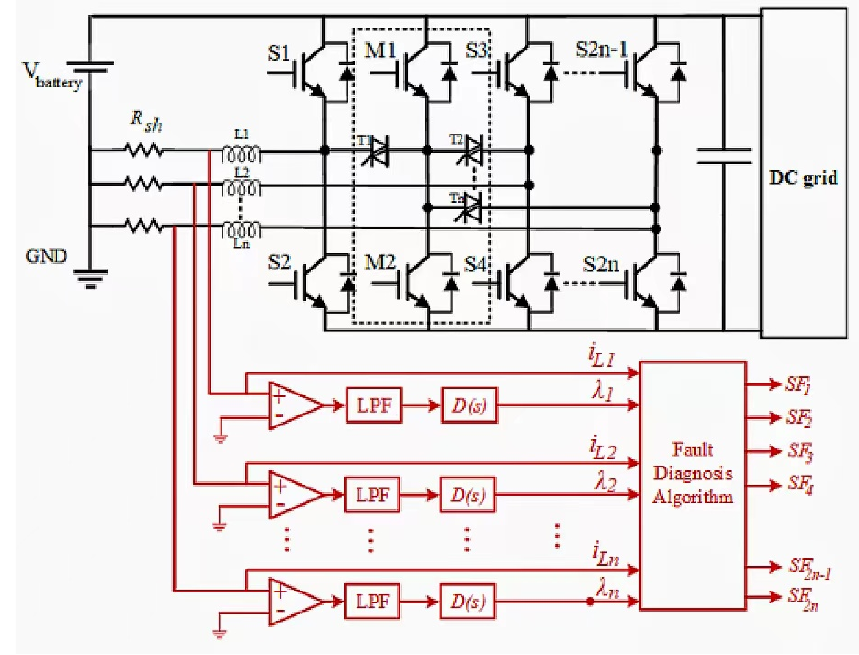
Figure 7. Proposed fault diagnosis scheme.